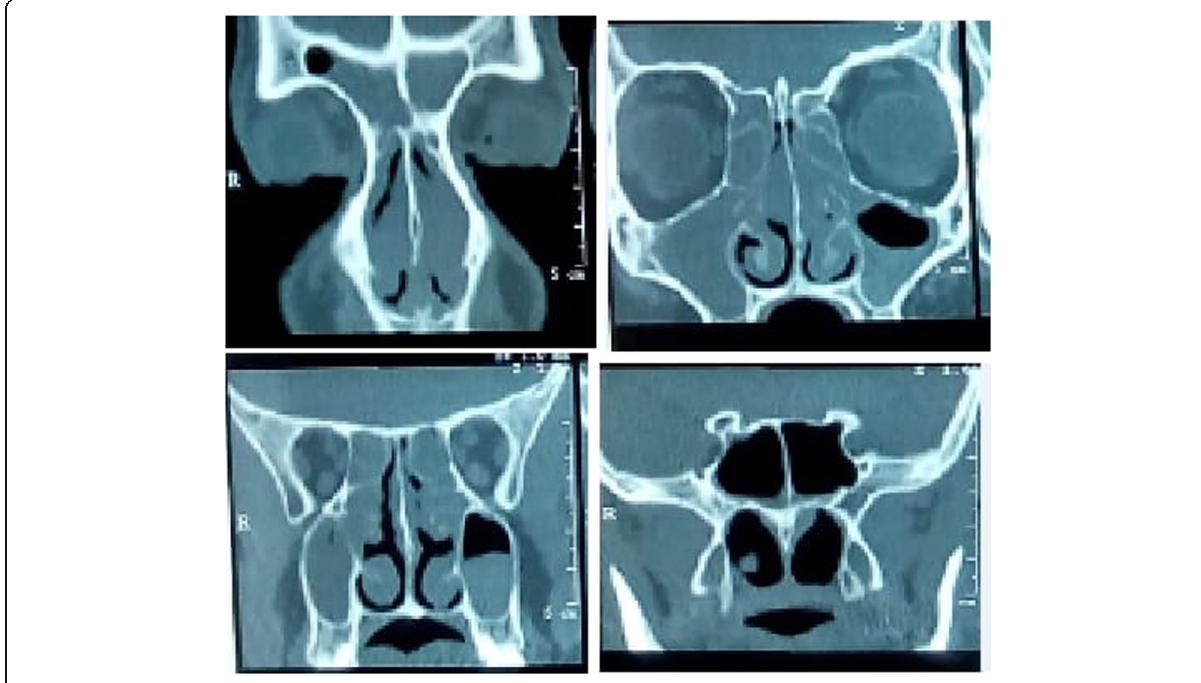
Fig. 5 CT PNS of case from injection group, before treatment